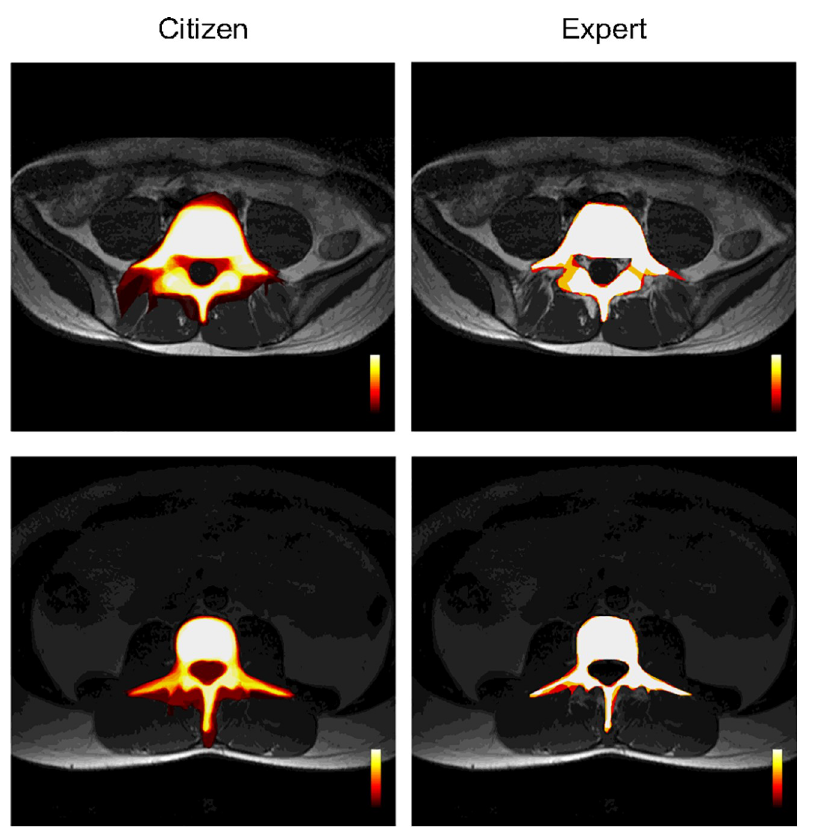
Fig 4. Consensus maps. Example consensus maps from citizens (left) and experts (right). The colour scale represents the number of segmentations and ranges from no segmentations (dark red) to all segmentations (white).